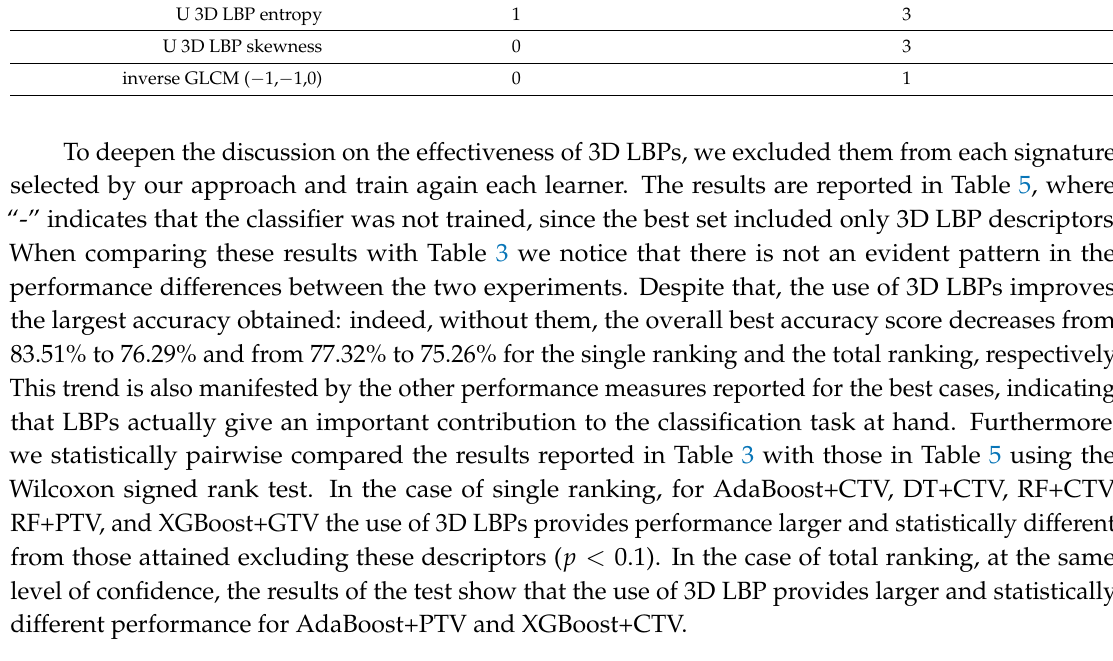
Table 5. System performance excluding LBP descriptors from the final feature subset in all possible combinations of Table 2 for single ranking (upper panel) and total ranking (lower panel). The notation ‘-’ indicates that no feature was left in the final set after excluding LBP descriptors. The largest performance is highlighted in